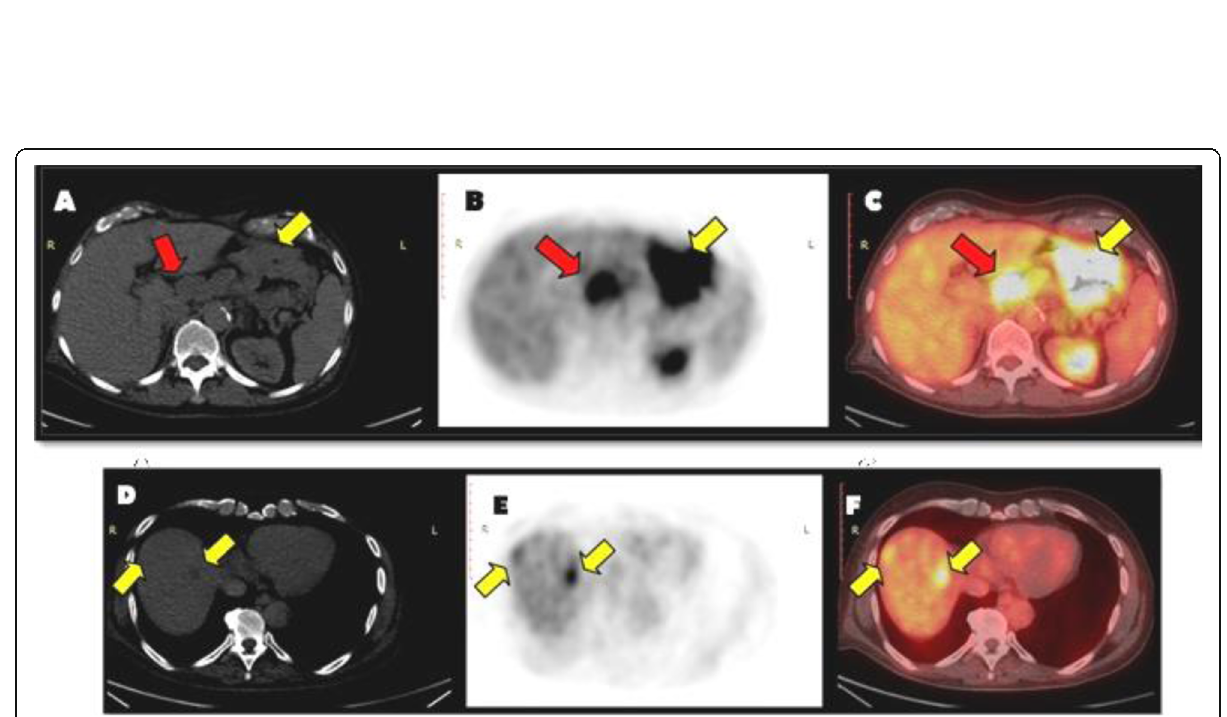
Fig. 3 Axial post-contrast CT, PET, and fused PET-CT images for a 69-year-old male patient with gastric carcinoma and had received chemotherapy . Images a – c showed FDG avid metabolically active irregular circumferential gastric mural lesions (yellow arrows) reaching 3.2 cm along the gastric fundus and body with SUVmax ~ 19.3, in addition to multiple hypermetabolic gastrohepatic and porta hepatis lymph nodes (red arrows); the largest measures 3.5 cm with SUVmax ~ 8.9. Images d – f showed few FDG avid metabolically active hypodense hepatic dome focal lesions (yellow arrows), the largest and the most active one measures 1.4 cm with SUVmax ~